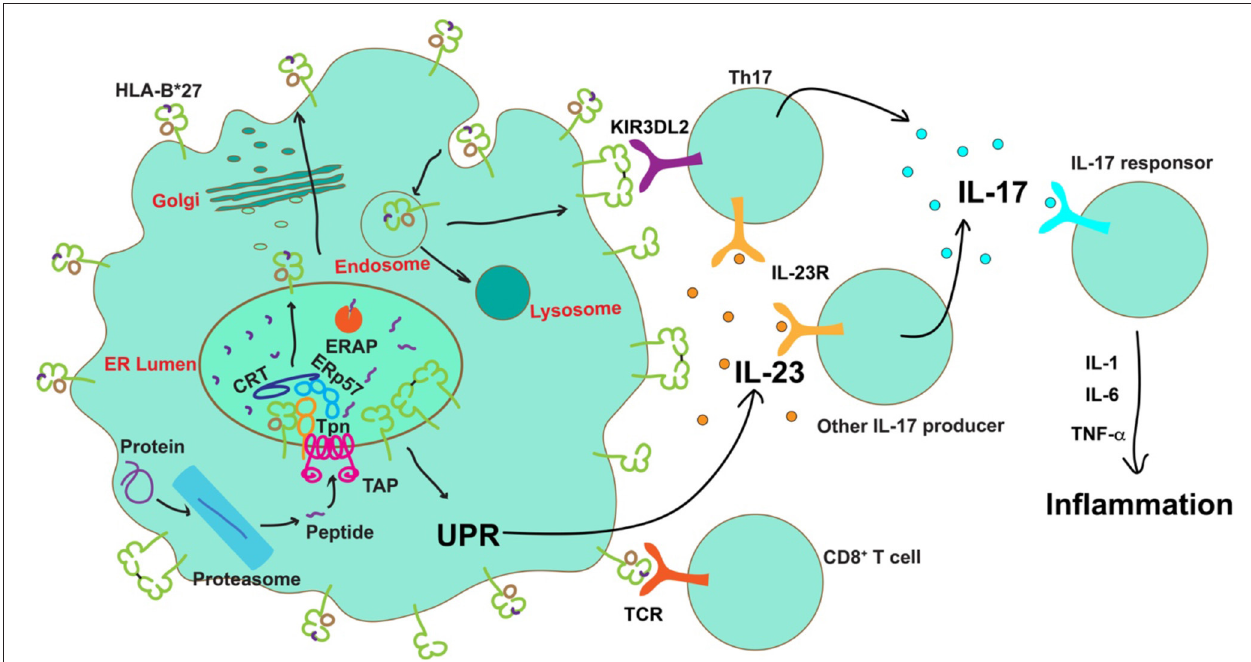
FIGURE 2 | Possible roles of HLA-B*27 in the pathogenesis of AS. After transport into the ER by the transporter associated with antigen processing (TAP), peptides are assembled onto nascent MHC class I molecules by the peptide loading complex (PLC), comprising TAP, tapasin (Tpn) calreticulin (CRT) and ERp57, and further trimmed by ERAP. The presence of certain ERAP haplotypes results in a significantly decreased number of peptides optimal for HLA-B*27, leading to accumulation of misfolded proteins in the ER or expression of sub-optimally or neoantigen-loaded HLA-B*27 on the cell surface. Neoantigen loaded HLA-B*27 on the cell surface could induce activation of CD8 + T cells. Protein misfolding in the ER can cause ER stress and activation of the unfolded protein response (UPR) to induce IL-23 secretion. IL-23 further activates the IL-23/IL-17 axis. On the other hand, free heavy chains or disulfide bond-linked homodimers of HLA-B*27 can be formed and expressed on the cell surface during HLA-B*27 recycling via the endocytic pathway. Engagement of these aberrant species by KIR3DL2 on the surface of Th17 cells is known to enhance their survival, proliferation, and IL-17 expression. IL-17 can promote the release of proinflammatory cytokines to establish